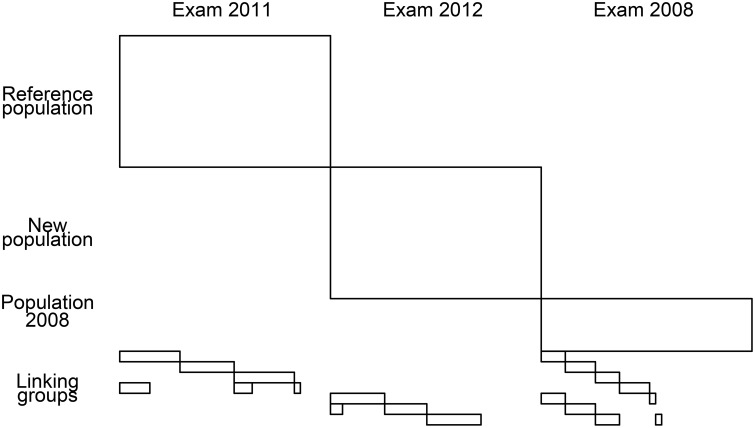
Equating design.